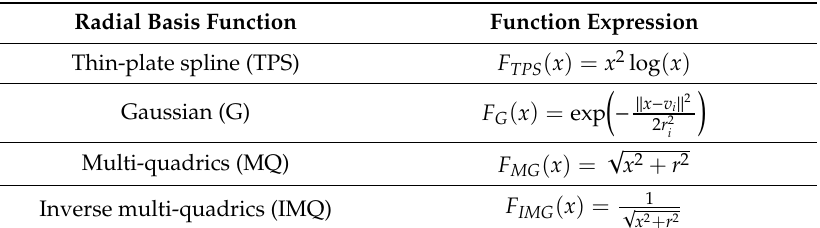
Table 1. Example of radial basis functions